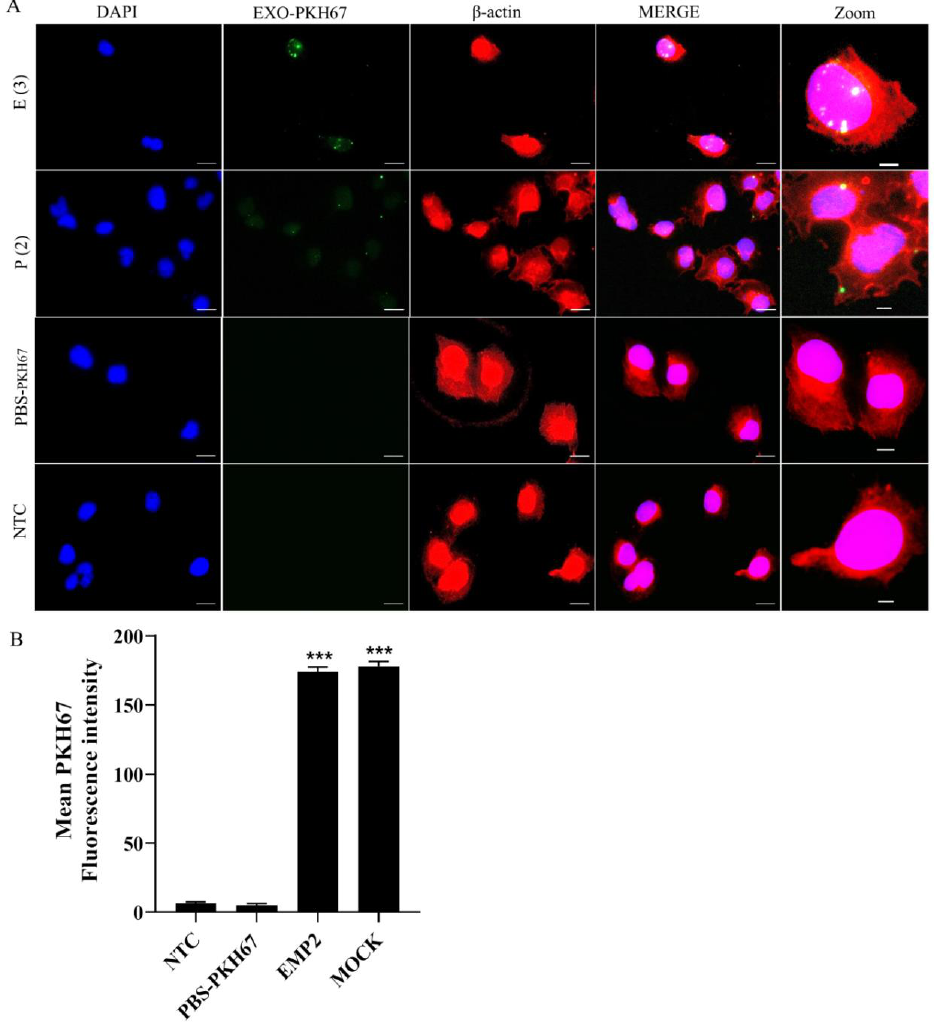
Figure 8. Uptake of exosomes by autologous cells. ( A ) Cellular uptake of autologous exosomes in H2170 cells imaged by confocal microscopy. The fluorescence of DAPI, β -actin, and that of EXOSOME-PKH67 are labeled with blue, red, and green, respectively. Scale bars: 10 µm. ( B ) Summary bar graphs of the relative mean fluorescence intensity (MFI) of PKH67 (exosomes) in recipient cells. The results are illustrated as the mean ± SEM of the relative MFI. *** p < 0.001 in comparison with nontreated cells (NTC) analyzed by one-way ANOVA with Bonferroni’s multiple comparisons test; E-Mock: Exosome of mock cells; E-EMP2: Exosomes of EMP2-transfected cells.